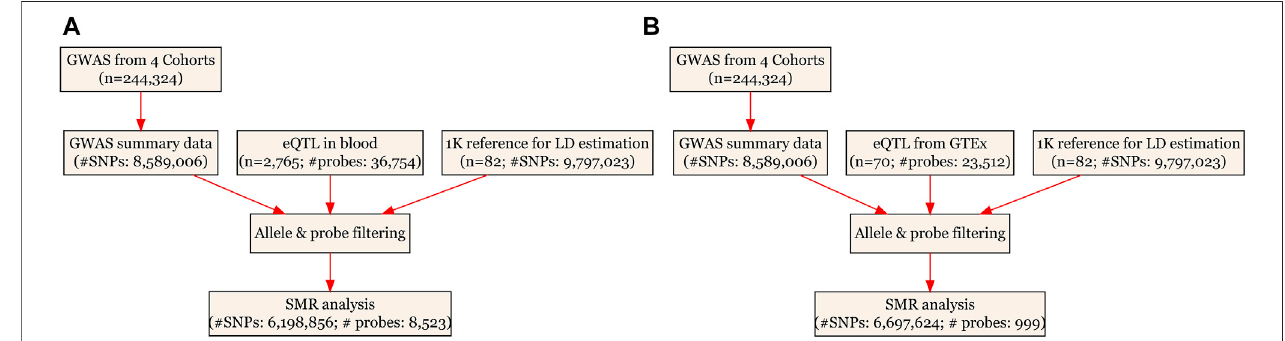
FIGURE 1 | Flow chart for the SMR analyses. (A) SMR analysis using CAGE eQTL data from blood; and (B) SMR analysis using GTEx eQTL data. CAGE, Consortium for the Architecture of Gene Expression; eQTL, expression quantitative trait loci; GWAS, genome--wide association studies; GTEx, Genotype--Tissue Expression; LD, linkage disequilibrium; SMR, summary data--based Mendelian randomization; SNP, single nucleotide